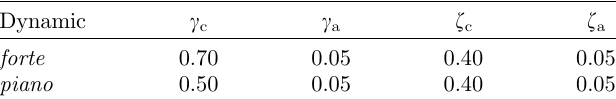
Table 3. Dimensionless control parameters used for digital synthesis following equations (10) and